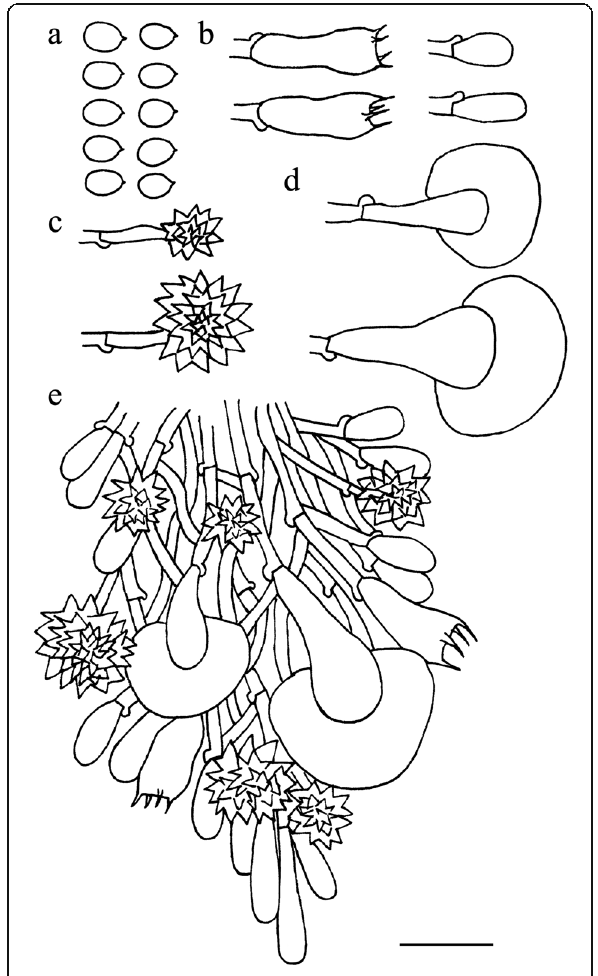
Fig. 7 Microscopic structures of Resinicium lateastrocystidium (drawn from holotype). a basidiospores. b basidia and basidioles. c astrocystidia. d halocystidia. e apical part of a tooth. Scale bar =10 μ